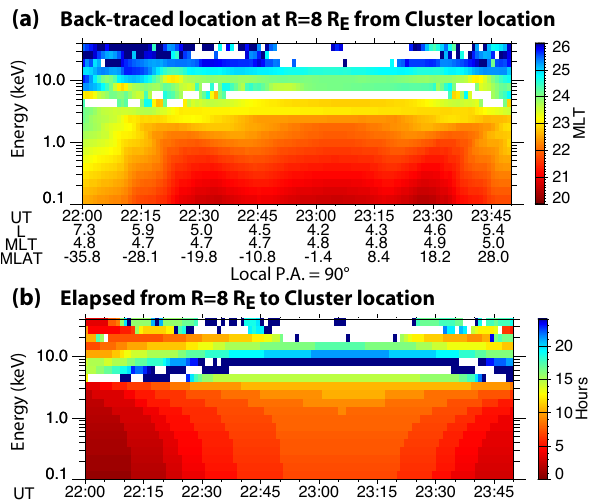
Fig. 3. Back-traced local time (upper panel) and estimated elapsed time (lower panel) from the satellite location to starting boundary at R =8 R E using backward phase-space mapping under assumed electric field and magnetic field (see text for the field model).